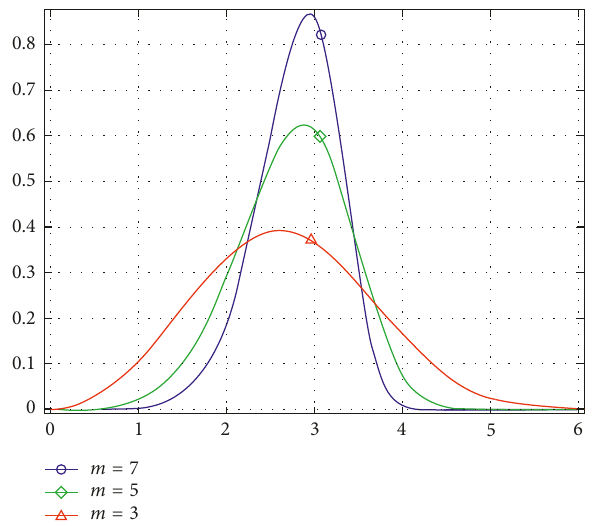
Figure 1: Weibull probability density function